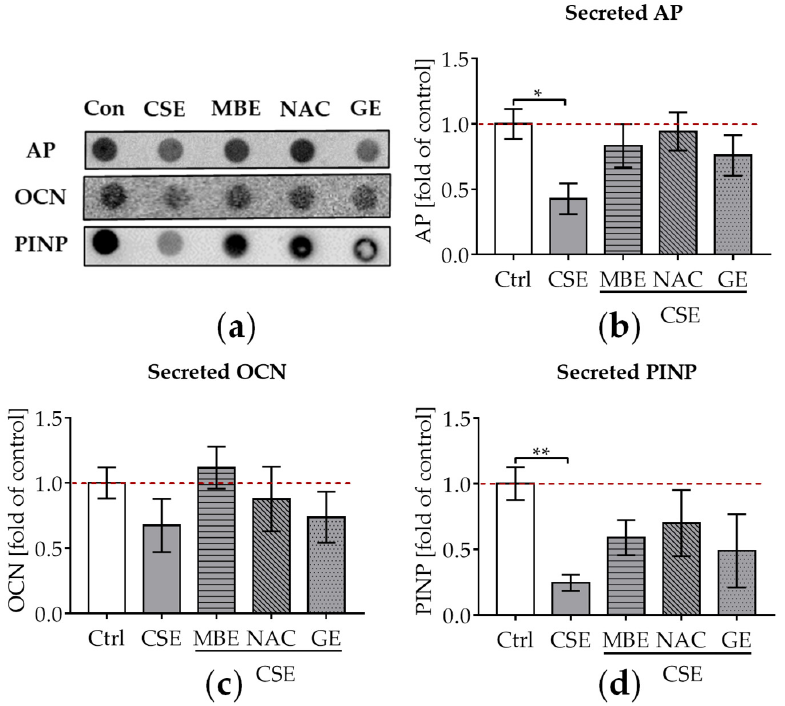
Figure 3. The influence of MBE and GE on CSE-impaired bone-forming function. After co-culture with osteogenic medium (2% FCS, 200 µ M L-ascorbic acid 2-phosphate, 5 mM β -glycerolphosphate, 25 mM HEPES, 1.5 mM CaCl 2 , and 5 µ M cholecalciferol) for 14 days, dot blot was performed to detect the secreted AP, OCN, and PINP in the supernatant. ( a ) A representative dot blot image showed the secreted protein levels of AP, OCN, and PINP in the 3D co-culture system with different treatments. ( b ) Secreted level of AP protein was measured in the co-culture system by day 14. ( c ) Secreted levels of OCN protein were measured in the co-culture system by day 14. ( d ) Secreted levels of PINP protein were measured in the co-culture system by day 14. Statistical differences were determined using the Kruskal–Wallis test followed by Dunn’s multiple comparison test. Data are presented as means ± SEM, and the significance is shown as * p < 0.05 and ** p < 0.01, vs. CSE group. N = 3, n = 3. In osteoclastogenesis, NF- κ B pathways were the first signaling pathways triggered by RANKL stimulation to be identified [38]. Therefore, we used WB and immunofluorescence to analyze NF- κ B and p-ERK1/2 protein levels in the co-culture system on day 7. With the WB analysis, we could detect the total protein level of NF- κ B in the co-culture system, while immunofluorescence staining showed the translocation of NF- κ B in the nucleus. The